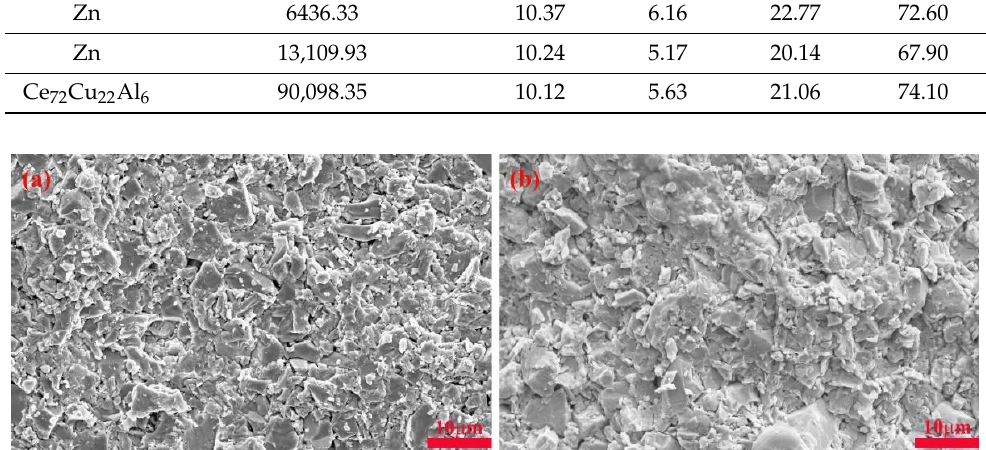
Figure 7. The cross-sectional morphology comparison of Zn and Ce 72 Cu 22 Al 6 alloy bonded Sm-Fe-N magnets with the addition of 5 wt.% of Al. Cross-sectional morphology of ( a ) Zn bonded magnet and ( b ) Ce 72 Cu 22 Al 6 bonded magnet.